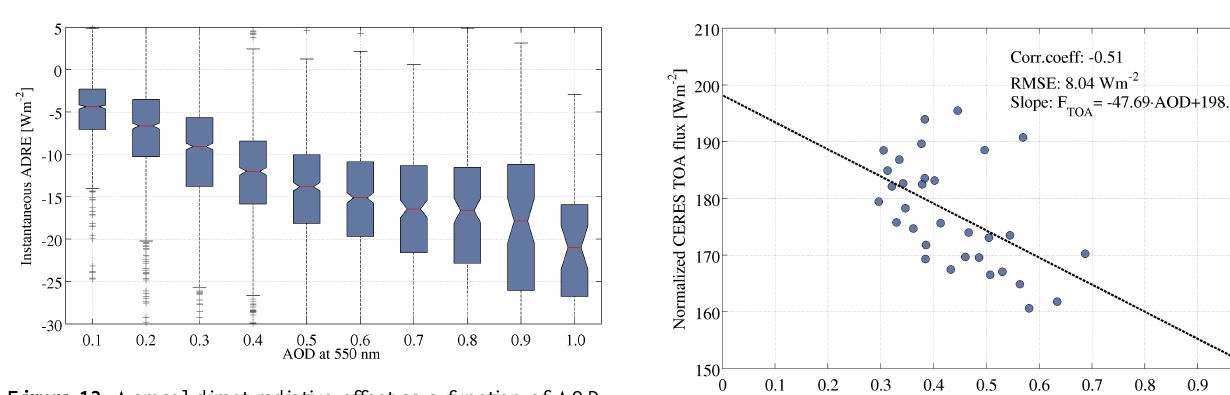
Figure 13. Aerosol direct radiative effect as a function of AOD. The AOD values denote the center of each 0.1 unit bin. Red central marks denote the median values of the ADRE, whereas the upper and lower edges of the box denote the 75th and 25th percentiles. Whiskers show extreme values and outliers are denoted by individ- ual “+” marks.